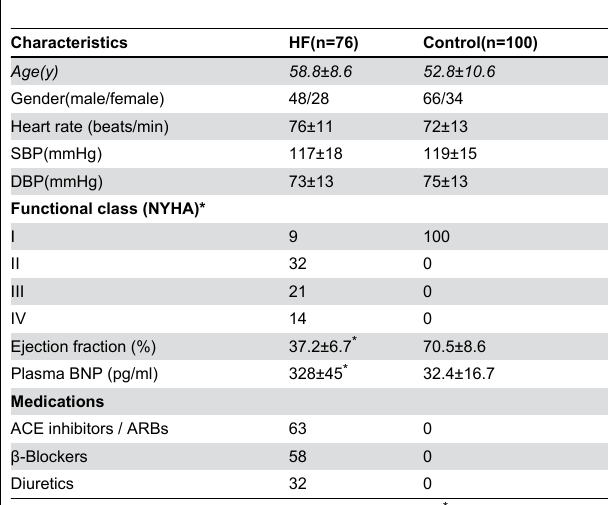
Table 1. Characteristics of patients with HF and healthy